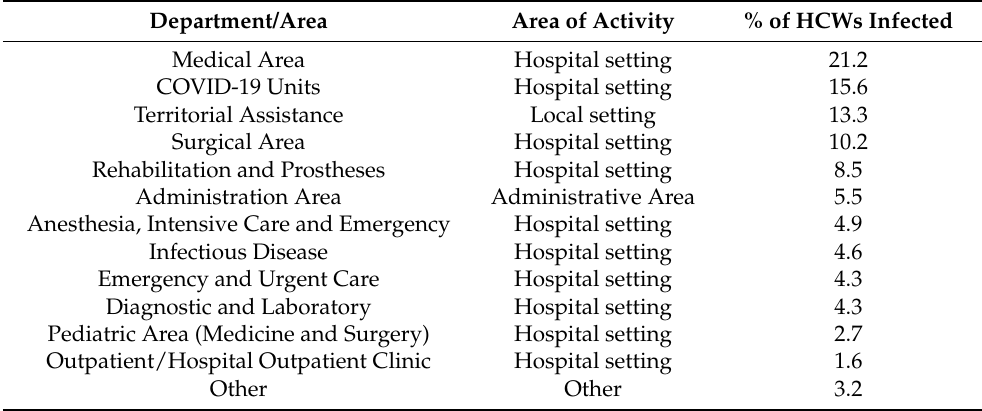
Table 2. Distribution by area of activity with details of hospital